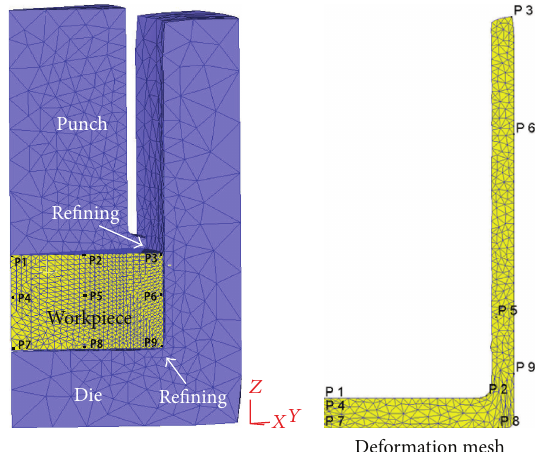
Figure 2: A comparison between predicted and measured peak stress with different temperature and strain rate. Figure 3: Mesh before and after deformation.